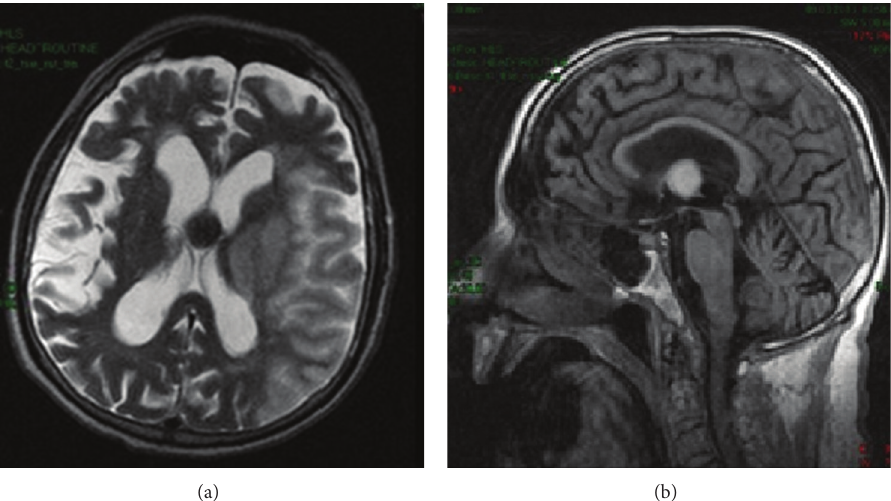
Figure 7: Colloid cyst. Round, well-demarcated lesion of third ventricle, hypointense on T2-weighted (a) and hyperintense on T1-weighted (b) MR images. Department of Neurology, Colentina Clinical Hospital brain imaging